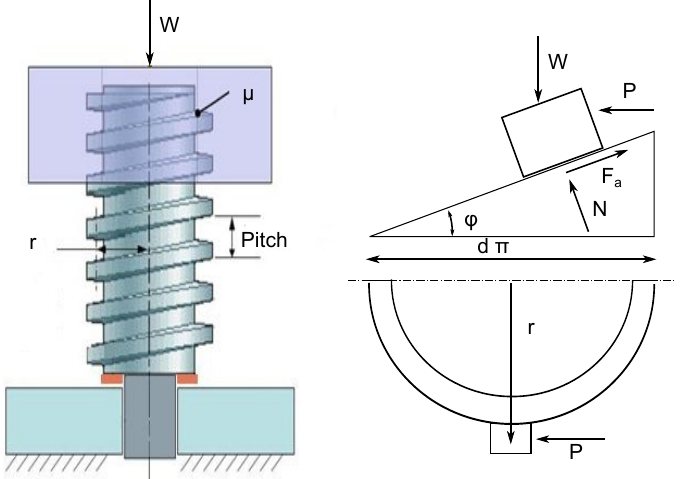
Figure 4. Representation of self-locking screw and equivalent mechanical model during down motion.